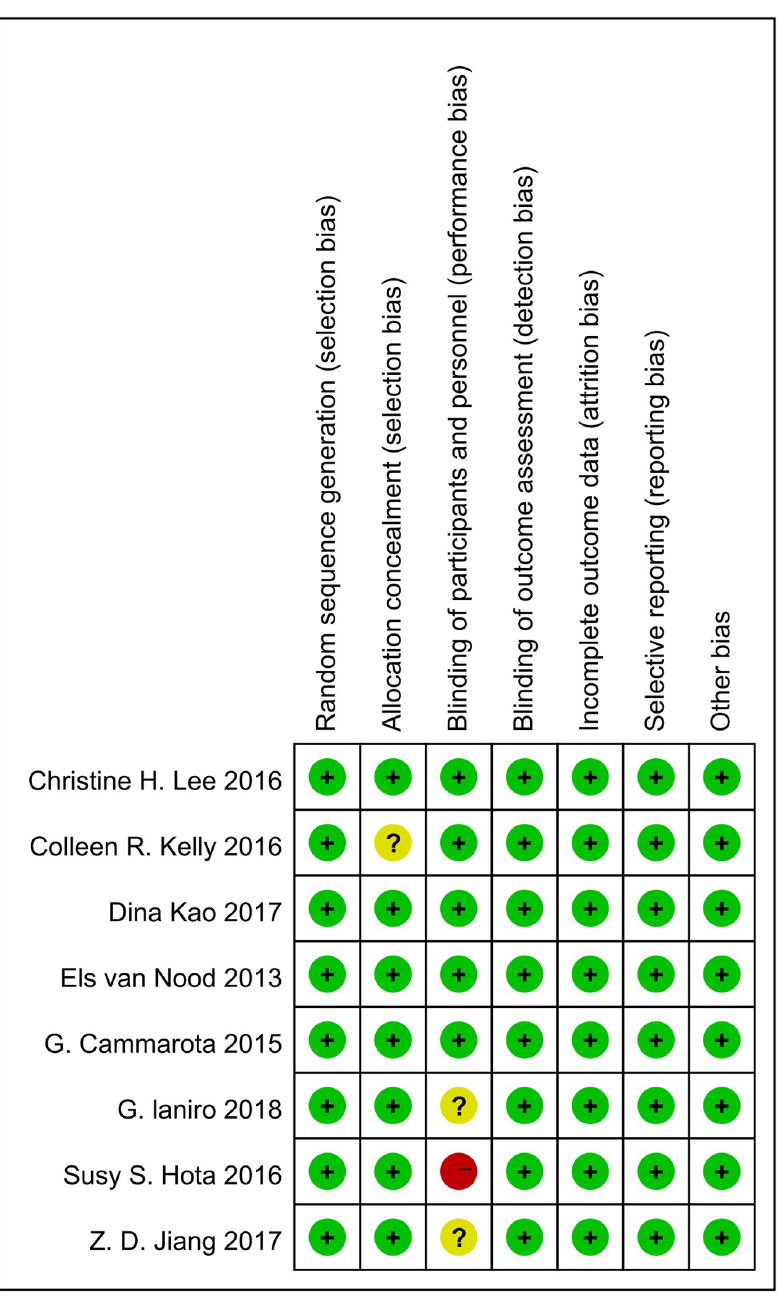
Adverse reactions associated with FMT for RCDI included fever, nausea, vomiting, fatigue, belching, abdominal pain or abdominal distention, diarrhea, and abdominal cramps and other